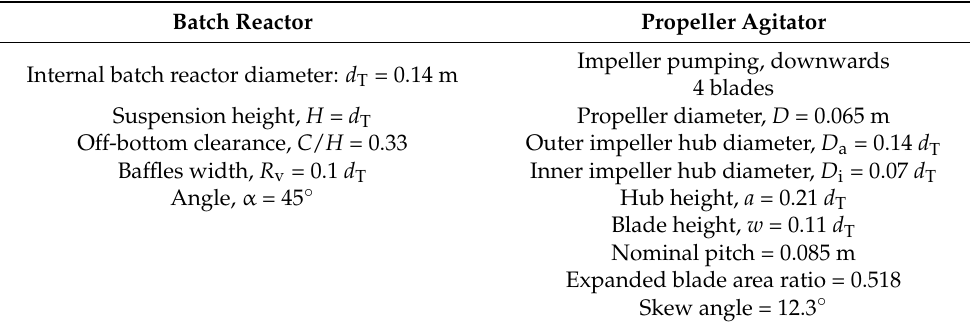
Figure 1. Design details of batch reactor ( a ) and propeller ( b ) ( d T —internal batch reactor diameter (m), H —suspension height (m), C —bottom clearance (m), R v —baffles width (m), α —angle (°), D — impeller diameter (m), D a —outer impeller hub diameter (m), D i —inner impeller hub diameter (m), a —impeller hub height (m), w —blade height (m)). Table 1. Batch reactor and impeller geometry characteristics.